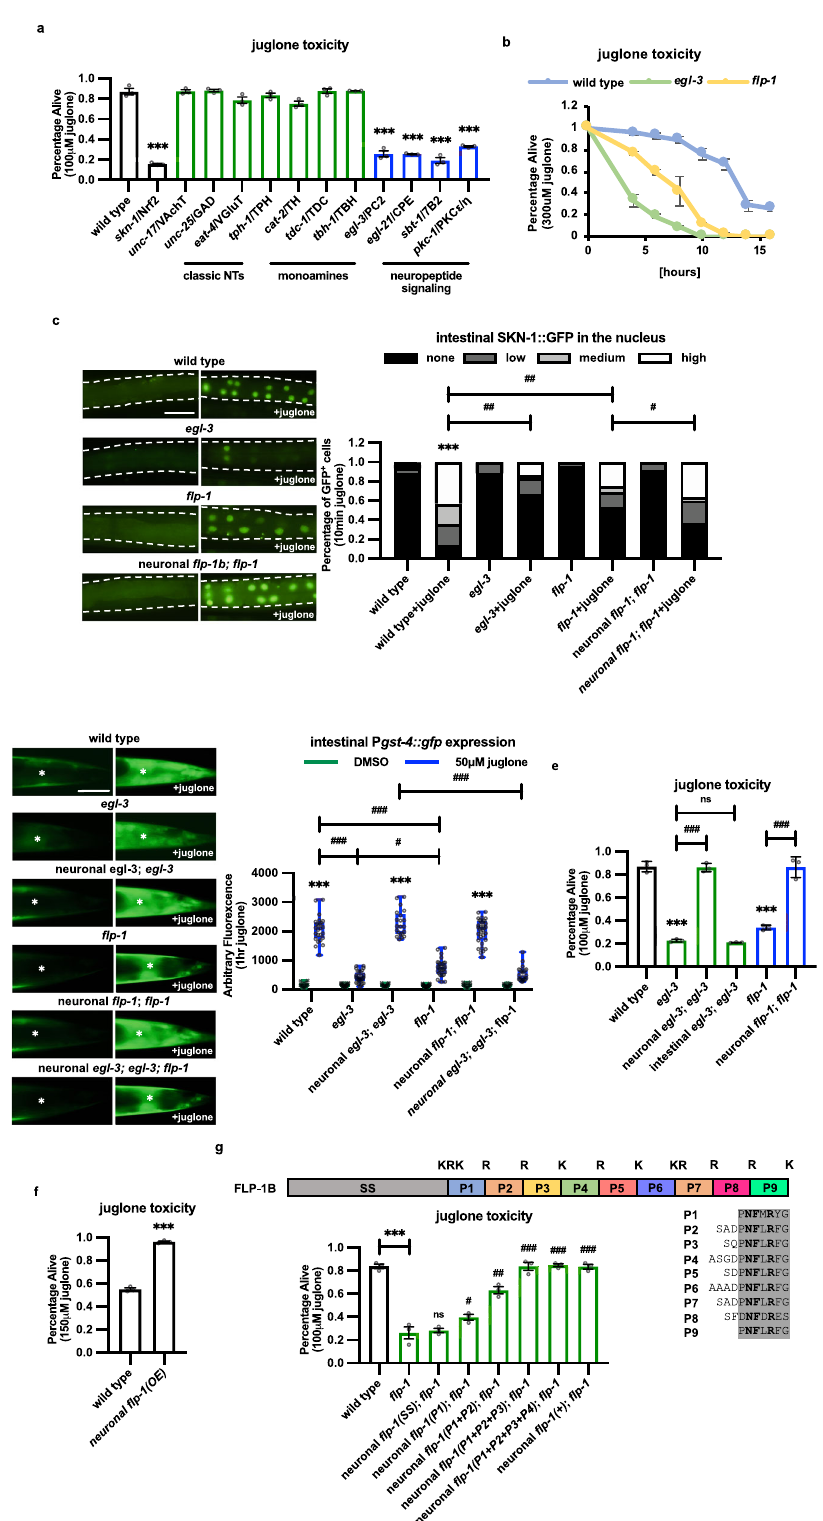
111 neuropeptide-like genes encoded by C. elegans for altered sensitivity to toxicity by juglone (Table S1). Knockdown of six toxicity compared to empty vector controls (Table S1).